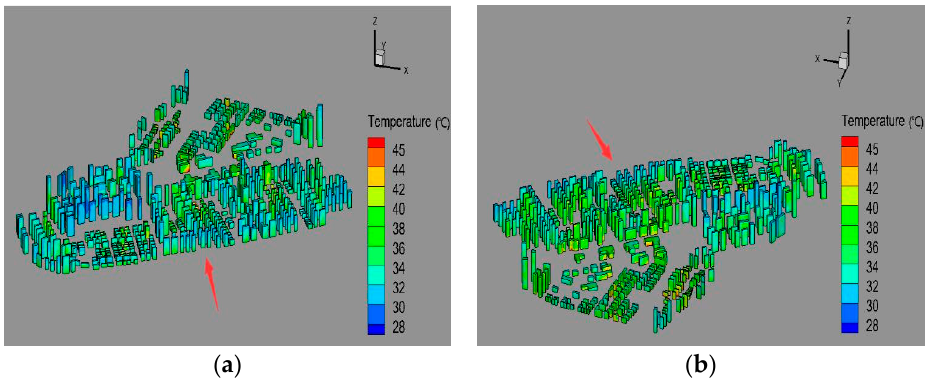
Figure 8. Temperature distributions on building façades in summer: ( a ) Windward; ( b ) Leeward.